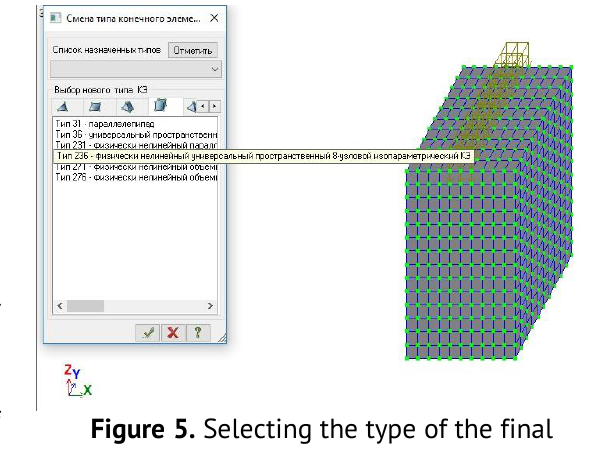
Figure 5. Selecting the type of the final element.